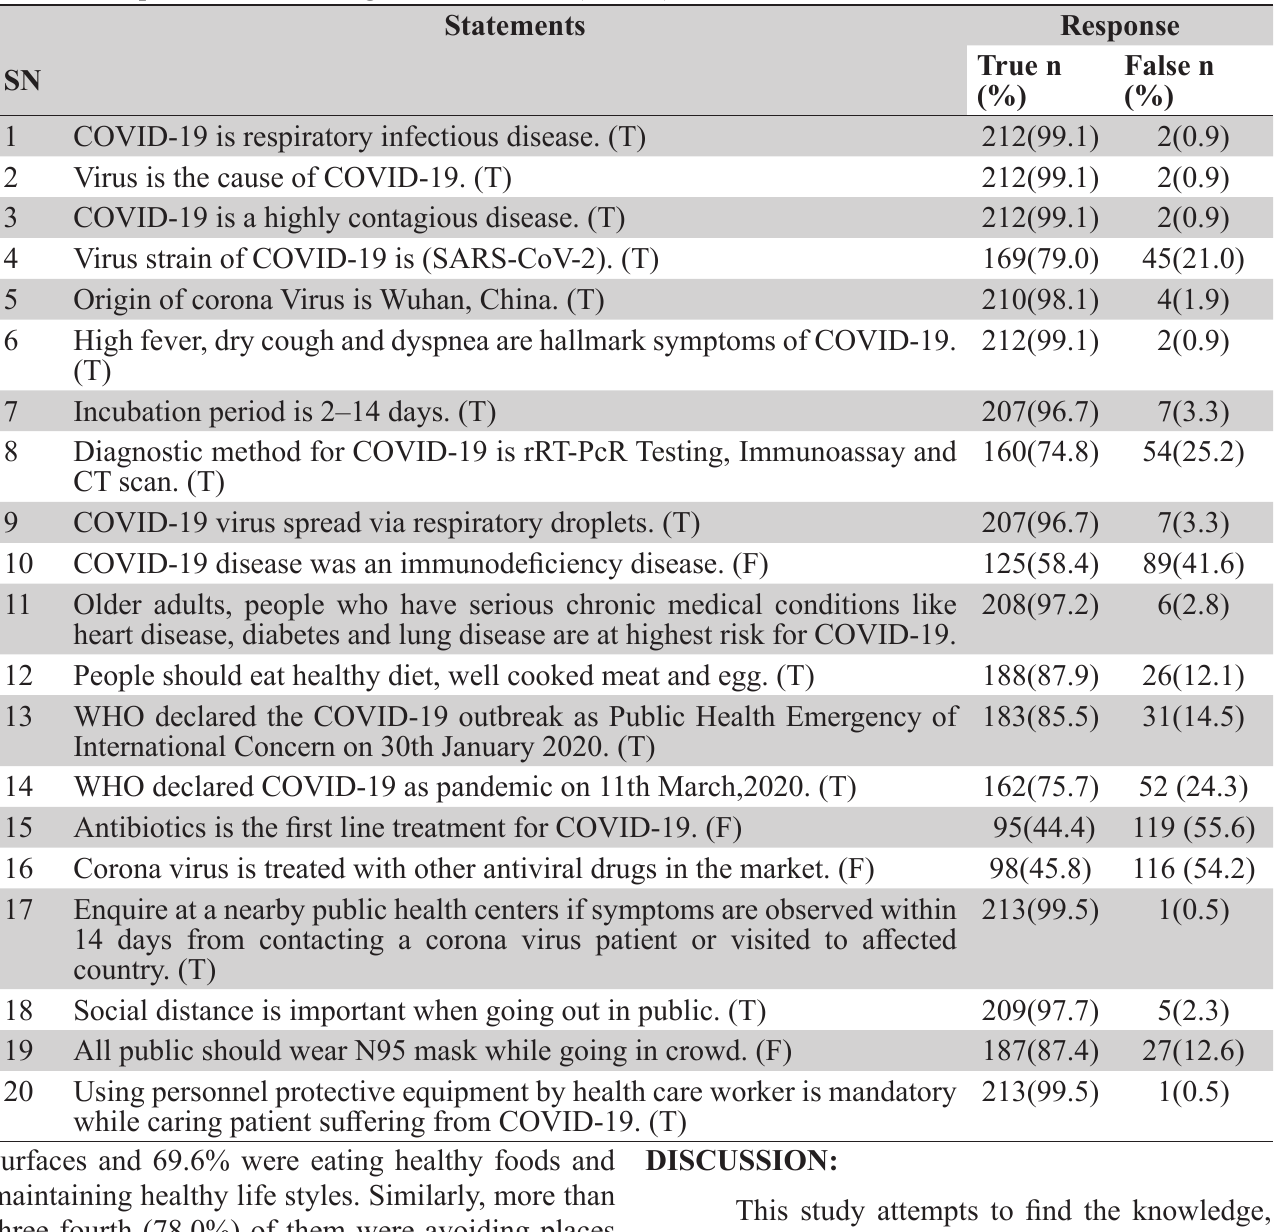
Table 1: Respondents’ knowledge on COVID-19 (n=214).